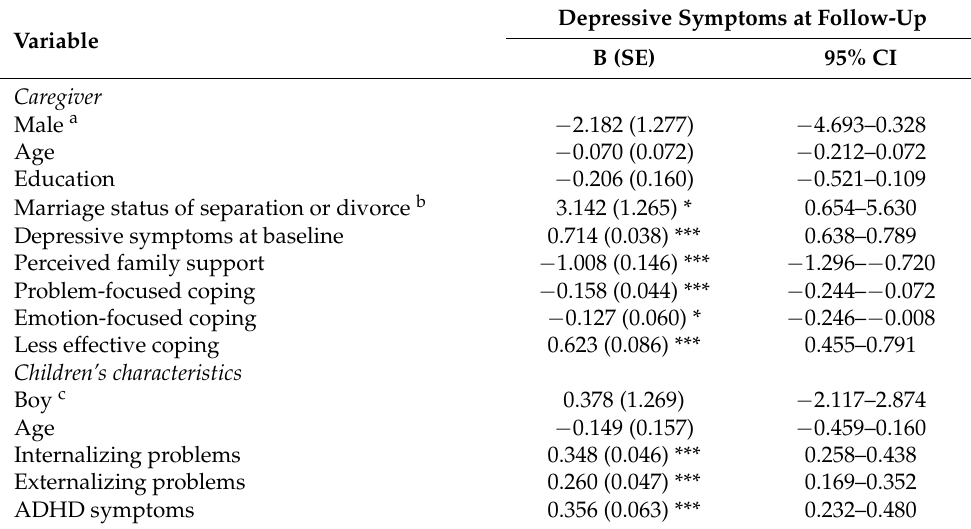
Table 2. Predictors of depressive symptoms at follow-up in caregivers of children with ADHD: univariate regression analysis.